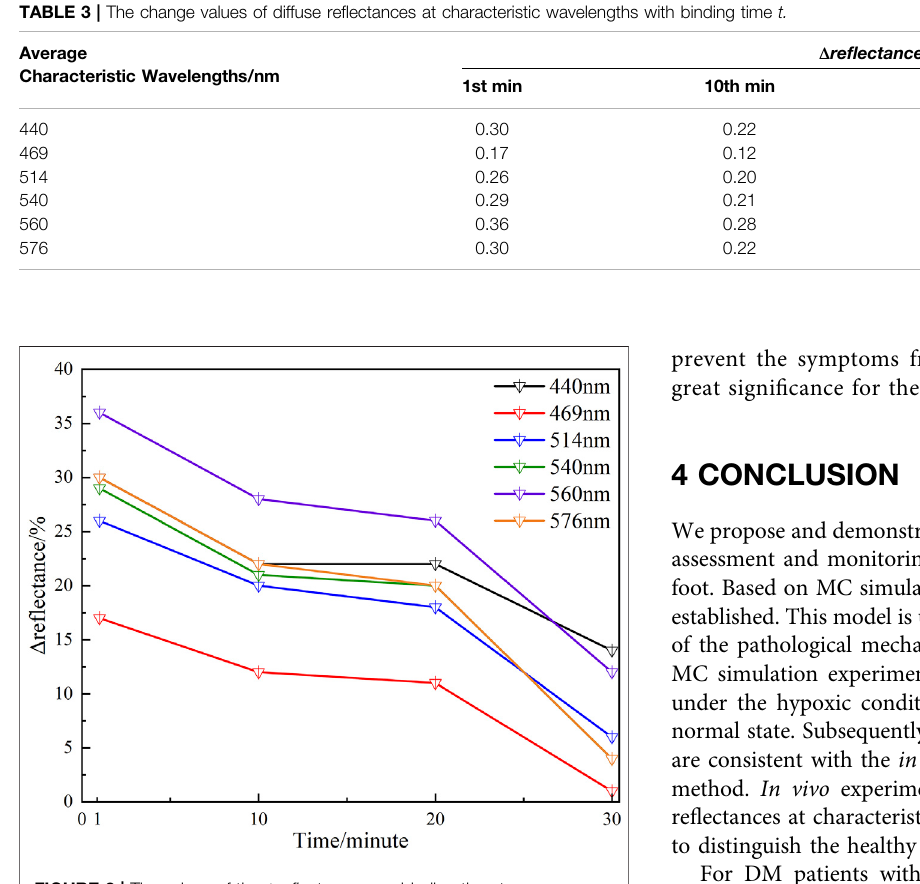
FIGURE 8 | The values of the Δ re fl ectance over binding time t